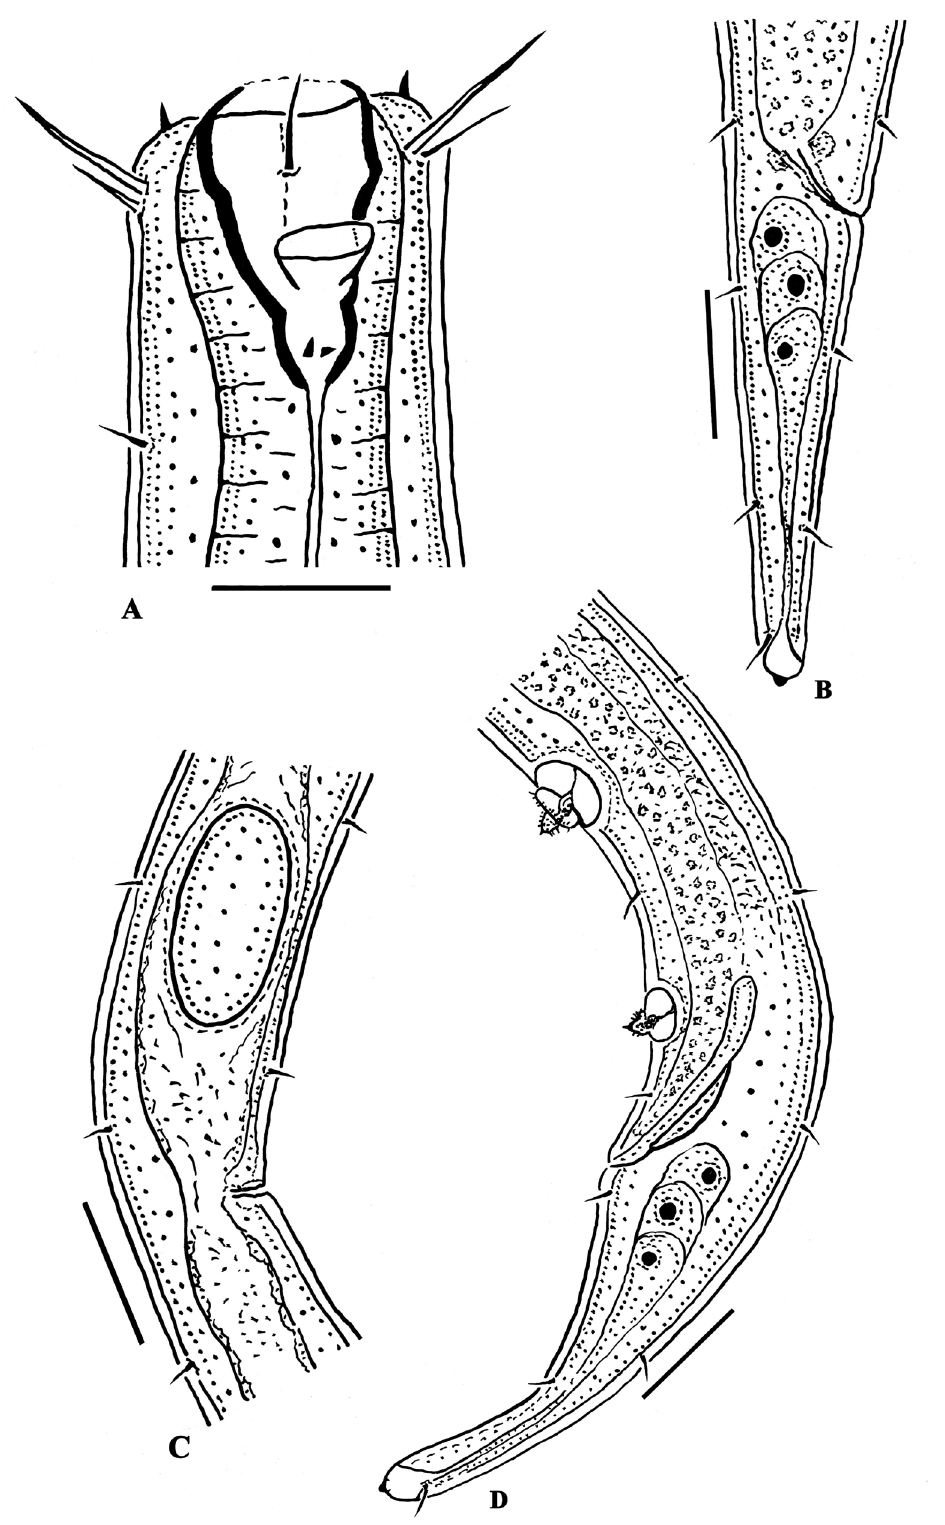
Fig. 1. Paratrilobus tankhoyensis sp. nov. A . Male anterior end. B . Female posterior end. C . Female vulva region. D . Male posterior body end. A, D: holotype (HM RAS 102/71 1538-2); B–C: paratype (HM RAS 102/71 1538-1). Scale bars: A = 30 µm; B = 60 µm; C = 80 µm; D = 40